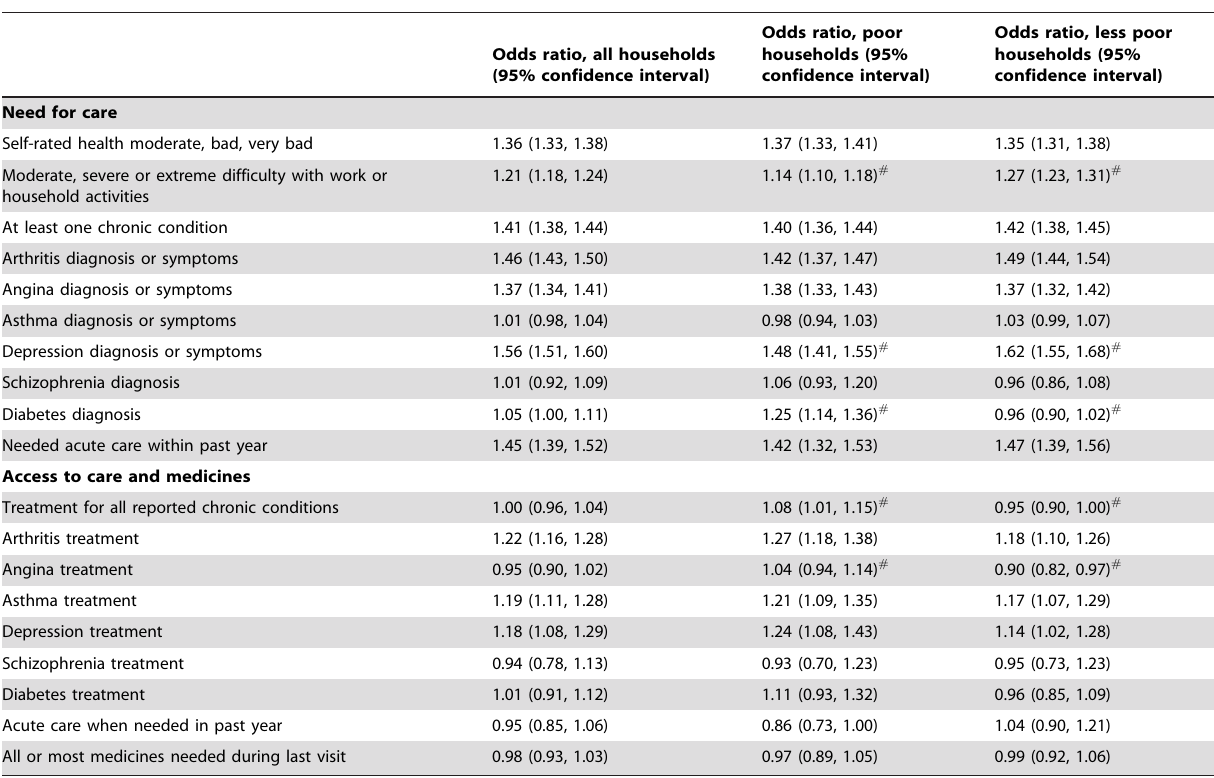
Table 4. Relationship of gender to need for, access to care among adult respondents*.